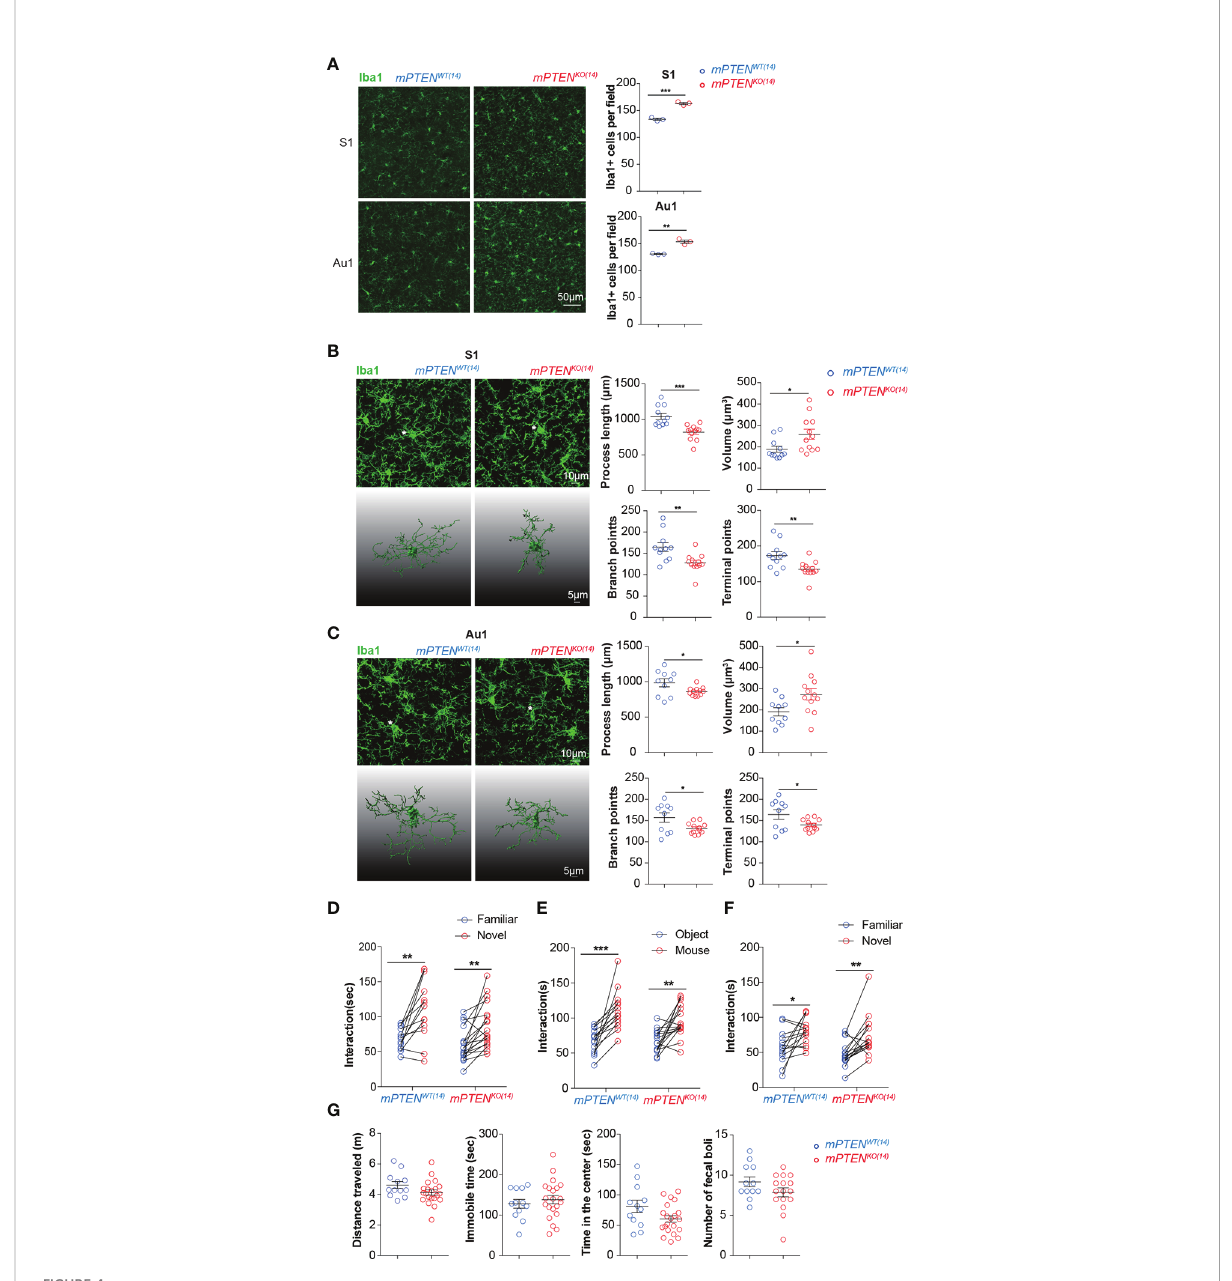
FIGURE 4 A critical window for microglia PTEN functions. (A) Representative images of Iba1-stained microglia in the S1 and Au1 cortex of mPTEN WT(14) and mPTEN KO(14) mice of 2-3 months of age. Right: numbers of Iba1 + microglia per fi eld (0.4 mm 2 ). Each dot represents a mouse (3 fi elds per mouse), and lines denote mean±s.e.m. (3 mice). (B) Left, maximum intensity projection images (top) and 3-D reconstruction of the asterisked microglia (bottom) from the somatosensory cortex (S1) of 2- to 3-month-old mice, mPTEN WT(14) or mPTEN KO(14) as indicated; Right, automated morphometric analyses of microglial process length, volume, number of branch points, and number of dendrite terminal points. Each dot represents one 3-D reconstructed microglia, and lines denote mean ± s.e.m. Data were collected from 3 mice, each contributing 3-4 randomly chosen microglia in the S1 cortex. (C) Microglia from the auditory (Au1) cortex, analyzed and presented exactly as in (B) . * P < 0.05, ** P < 0.01, *** P < 0.001, by unpaired t tests. (D) Time spent exploring a novel versus a familiar object by mPTEN WT(14) (n=13) or mPTEN KO(14) (n=18) mice in the novel object recognition test. (E, F) Time spent interacting with an inanimate object or a mouse (E) , a familiar or a stranger mouse (F) by mPTEN WT(14) (n = 14) or mPTEN KO(14) mice (n=16) in the three-chamber test. (G) Locomotor activities in the open- fi eld test. Total distance traveled (m), total time of being immobile (sec), total time of being in the center (sec), and number of fecal boli left by individual mPTEN WT(14) (n = 12) and mPTEN KO(14) (n = 12) mice. * P < 0.05, ** P < 0.01, *** P < 0.001 by unpaired (open fi eld) or paired (novel objection recognition and three-chamber interaction) t